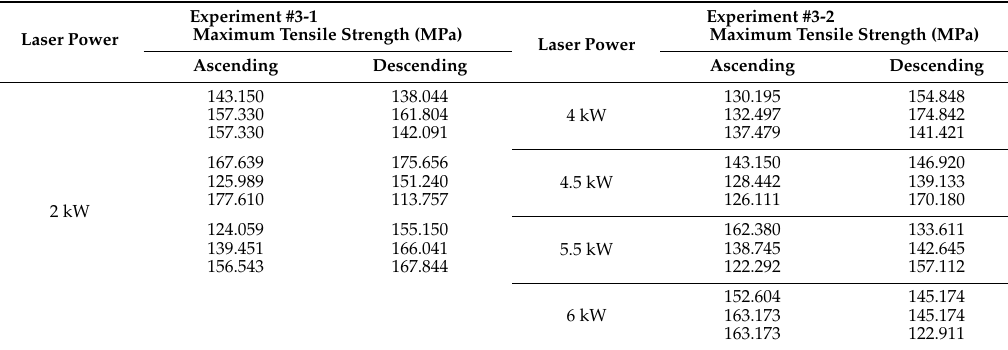
Table 14. The laser welding experimental data of experiment #3-1 (laser power: 2 kW, part-to-part